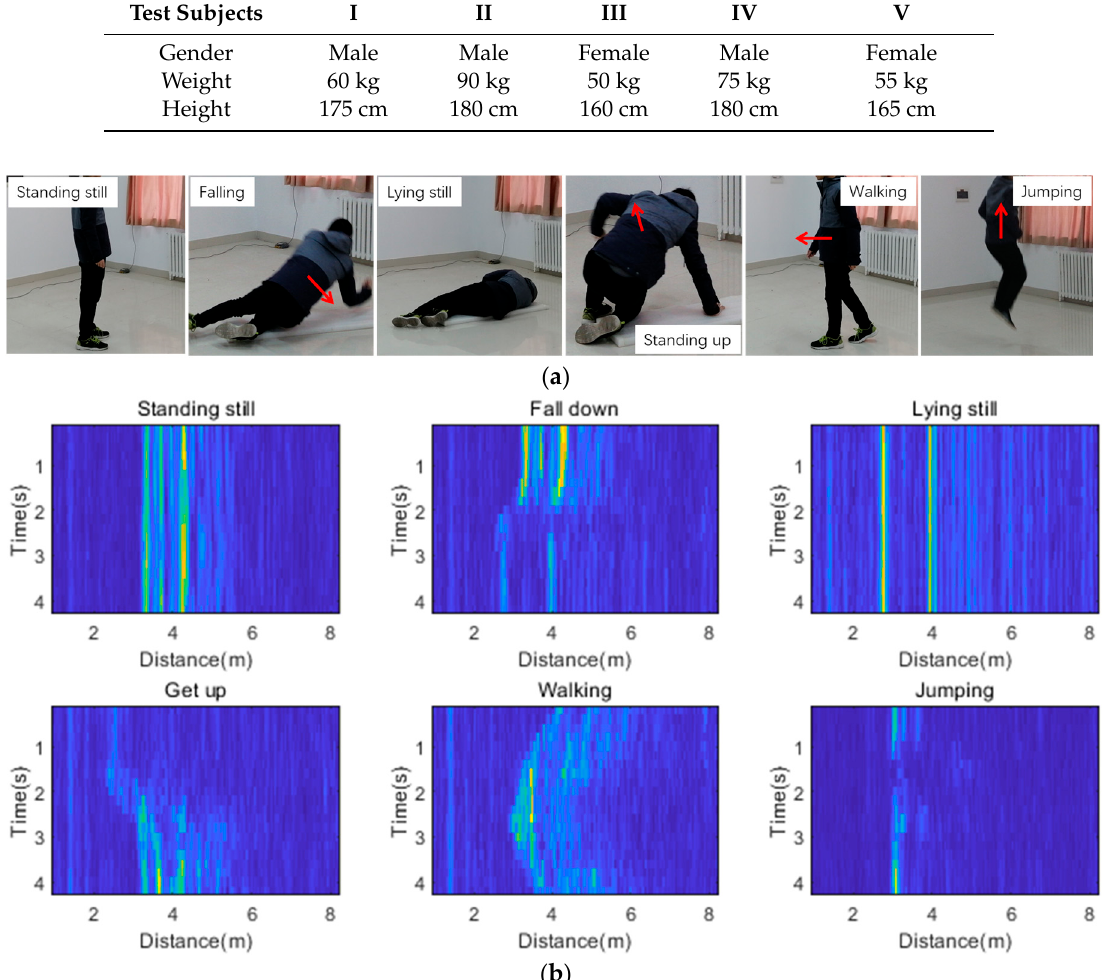
Figure 4. ( a ) The six activities considered in this work. ( b ) Training data examples with 20 frames per sample. Note that the samples in the picture covered the distance from 0.9 to 8.2 m. The size of the samples was 20 ◊ 800. Table 2. The gender, weight, and height of the test subjects.